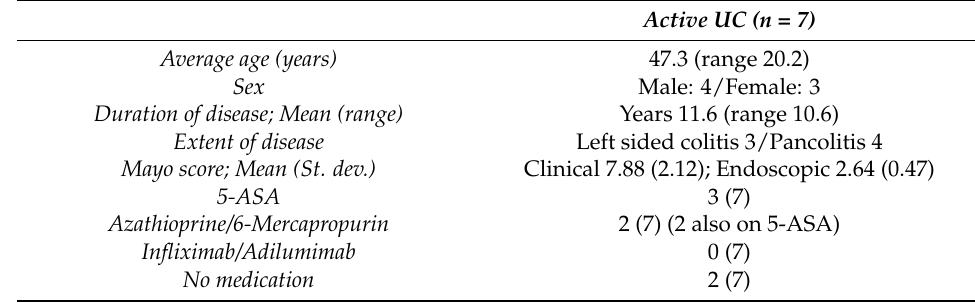
Table 4. Demographic data of patients used for explant culture analysis. n: number of subjects; St. dev.: standard deviation; 5-aminosalicylic acid: